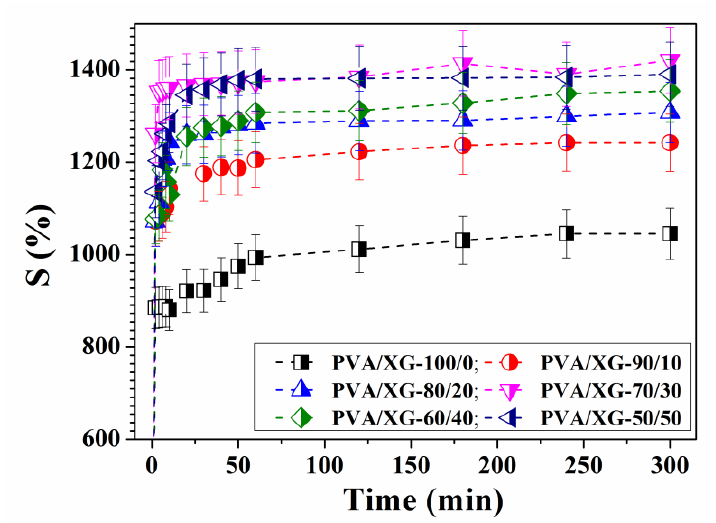
Figure 6. Swelling profiles in phosphate buffer pH 7.4, at 37 °C of PVA/XG